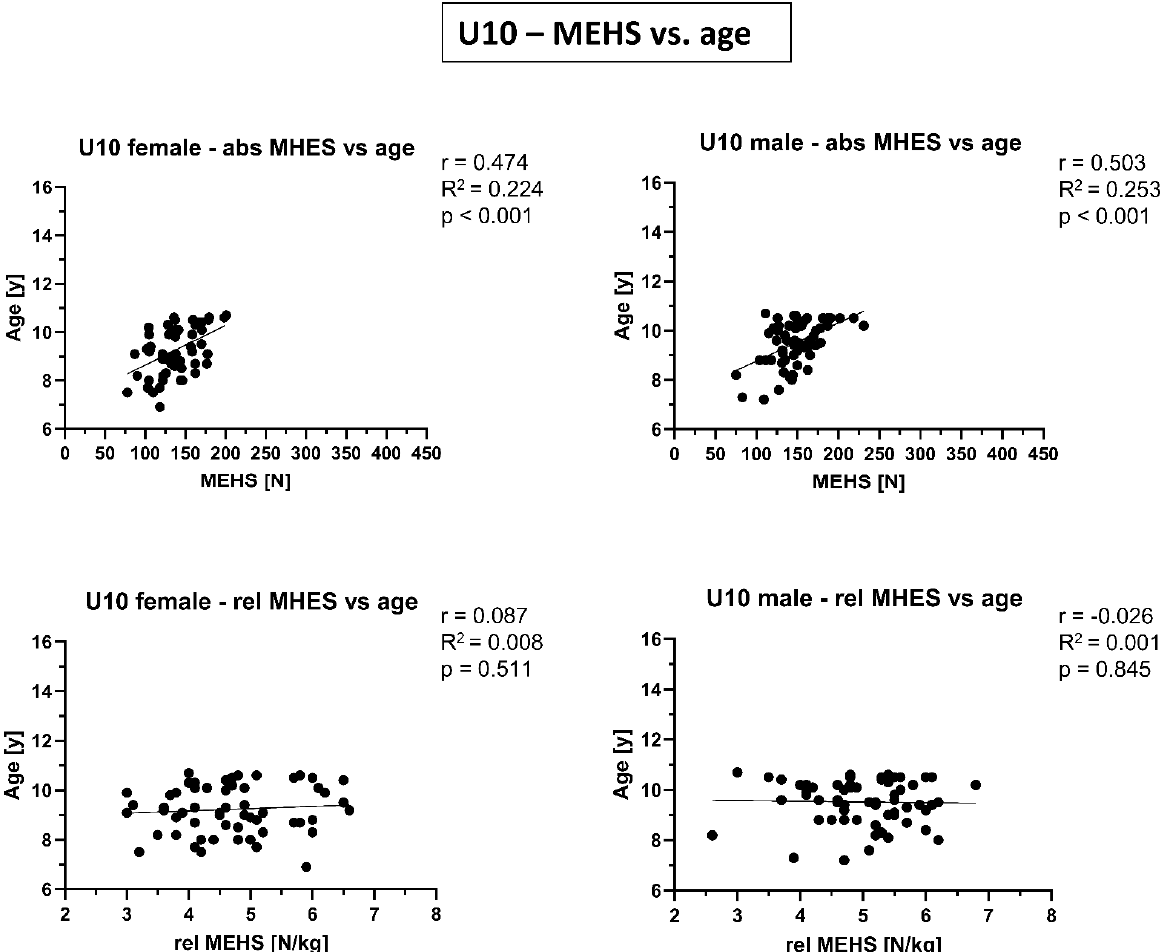
Figure 2. Correlations of absolute (abs) and relative (rel) maximal eccentric hamstring strength (MEHS) with age for competitive alpine skiers under 10 years old (U10) separated by sex.